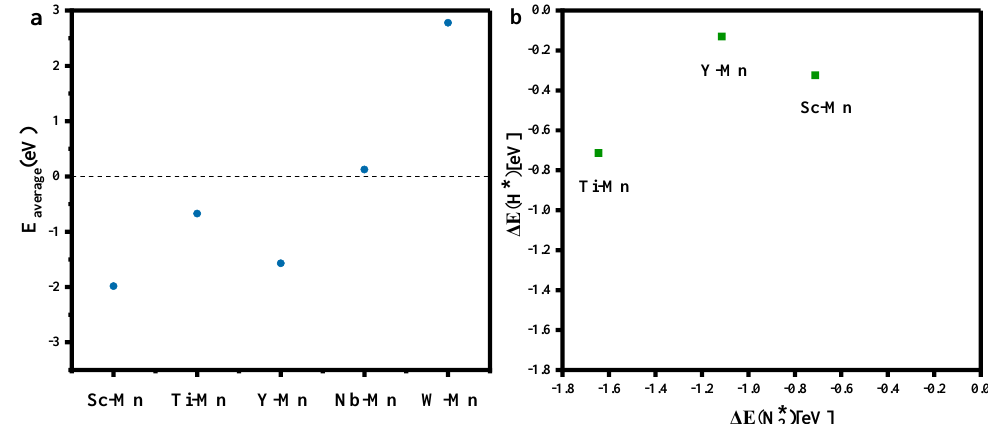
Figure 2. ( a ) Different TMs embedded in N-doped graphene comparison plot of the average bind- ing energy of atoms; ( b ) Comparison of adsorption energies of electron-coupled protons and free N 2 molecules.